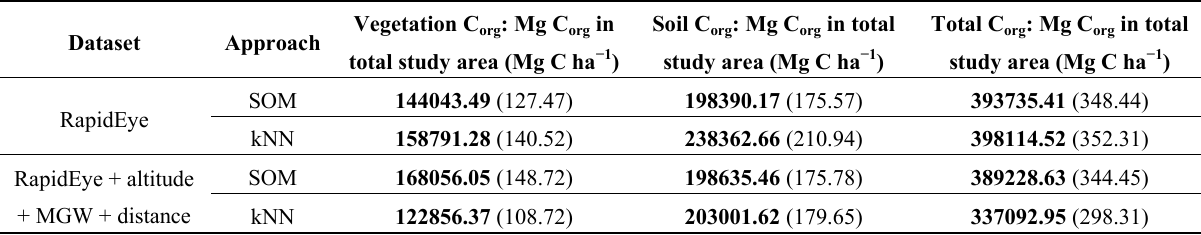
Table 2. SOM- and kNN-based estimates for vegetation, soil and total C Danube Floodplain.